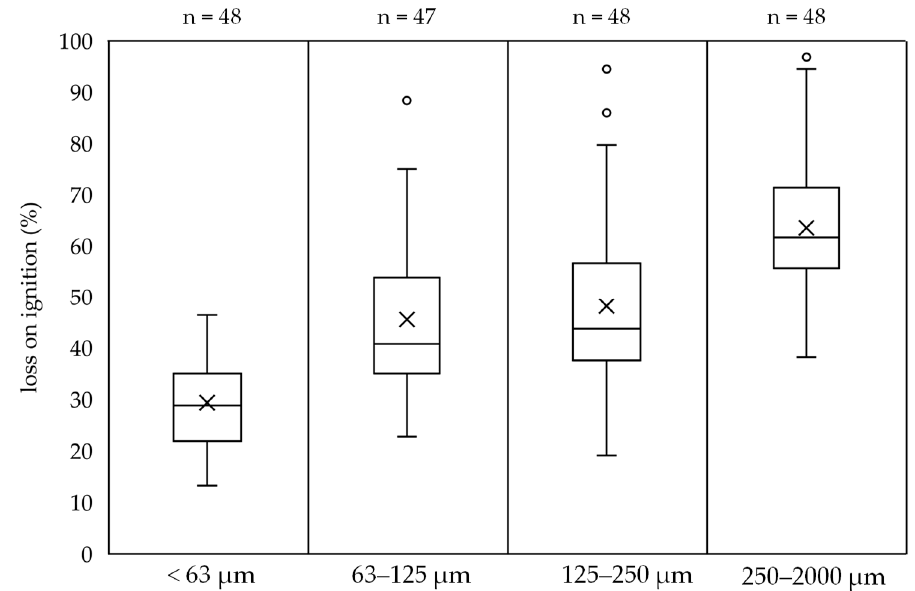
Figure 5. Distribution of the loss on ignition (LoI) on sample basis in four different particle size fractions (<63 µm, 63–125 µm, 125–250 µm, and 250–2000 µm).